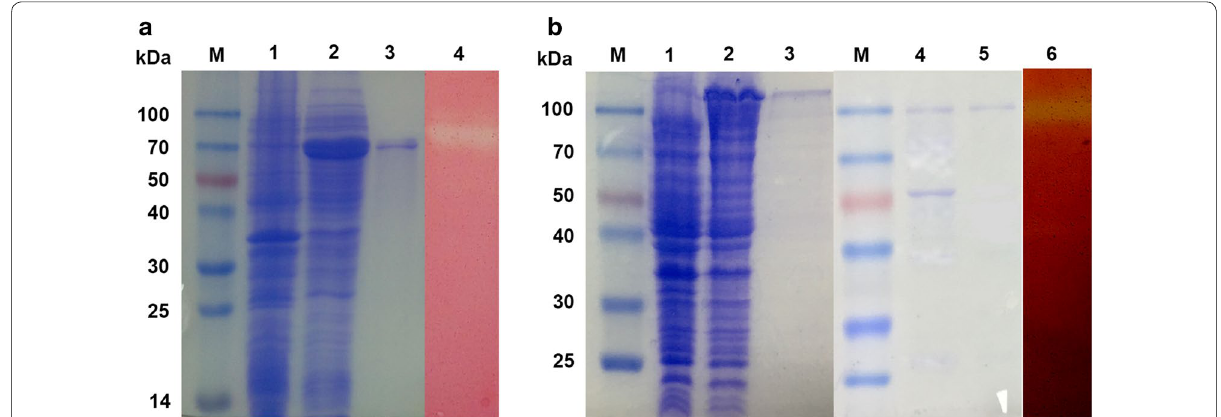
Fig. 2 SDS-PAGE and zymogram of recombinant enzyme Cel5A ( a ) and Cel9A ( b ). Lane M molecular mass markers; a Lane 1 total protein of cells without induction, Lane 2 total protein of cells induced with IPTG, Lane 3 purified recombinant Cel5A, Lane 4 zymogram of purified Cel5A; b Lane 1 total protein of cells without induction, Lane 2 total protein of cells induced with IPTG, Lane 3 purified MBP fusion protein, Lane 4 fusion protein digestion by Factor Xa, Lane 5 purified recombinant Cel9A, Lane 6 zymogram of purified